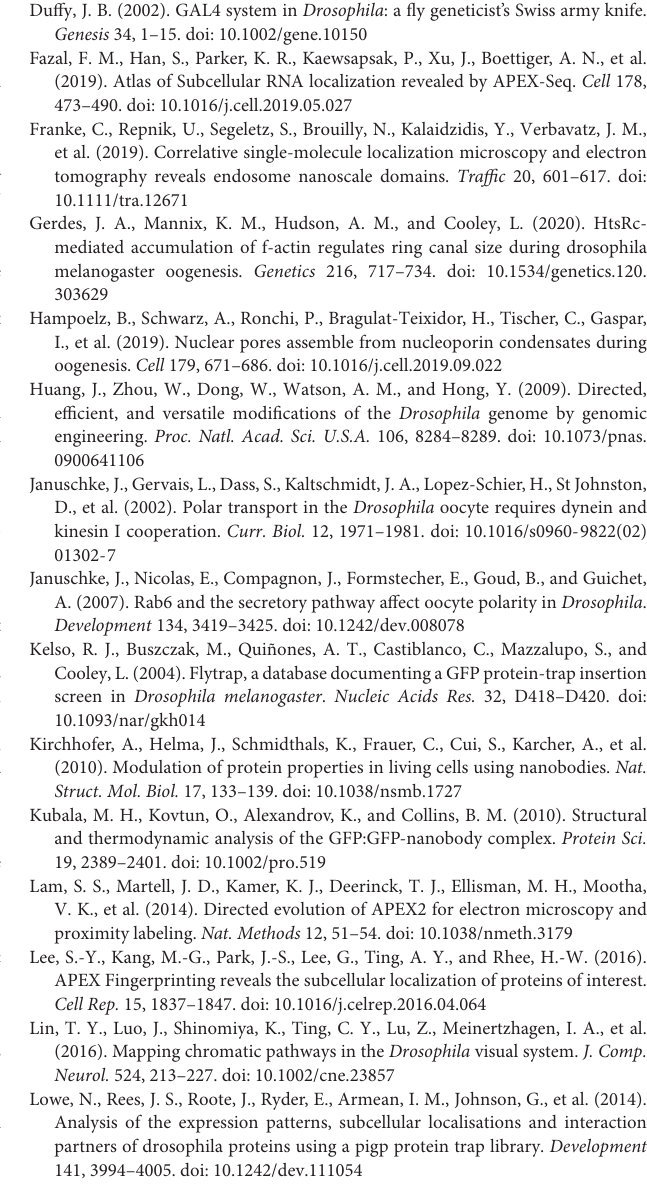
Supplementary Figure 2 | (A) Examples of non-specific staining independent of APEX in Golgi apparatus. (B) Negative control of APEX experiment. The APEX procedure was realized on mud 4 / mud 4 ; P(mud BAC . GFP )/P(mud BAC . GFP ). In absence of APEX2-GBP, we revealed only the cell structures. (G) Golgi apparatus, (N) nuclei, (m) mitochondria, (PM) plasma membrane, (ER) endoplasmic